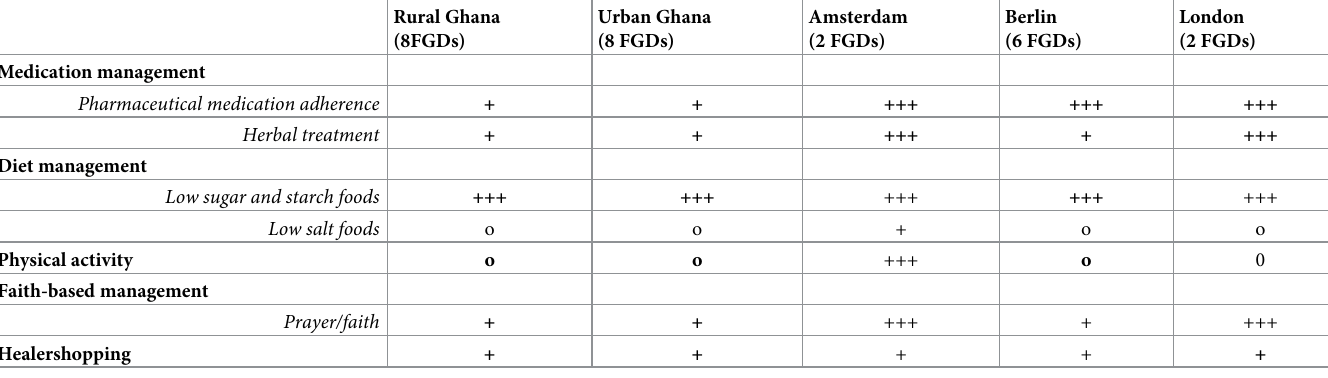
Table 4. Spread and dominance of ‘functions of T2D knowledge’ across the five study